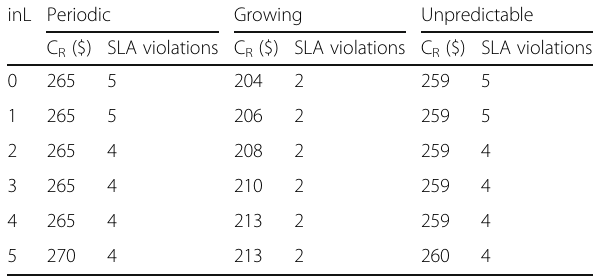
Table 12 Impact of increasing inL on the cost factors inL Periodic Growing